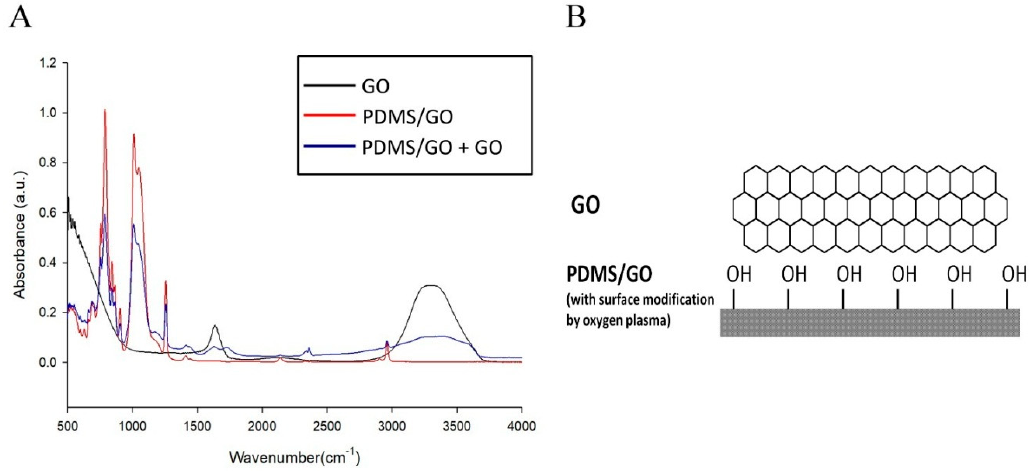
Figure 1. The FTIR analysis of graphene oxide (GO)-coated Polydimethylsiloxane (PDMS) incorporated with graphene oxide (PDMS/GO + GO) showed both PDMS- and GO-characteristic peaks. Peaks at 1100 cm − 1 represent the Si–O group. ( A ) FTIR analysis of PDMS/GO, GO, and GO-coated PDMS/GO. The FTIR spectra profile demonstrated that GO contained hydroxyl group, C–C, and C=C stretching, while PDMS/GO is characterized by the Si–O–Si spectra. PDMS/GO contained hydroxyl, C–C, C=C, and Si–O–Si groups with different absorbance intensity. ( B ) The predicted chemical structure of PDMS/GO with GO coating (PDMS/GO + GO).